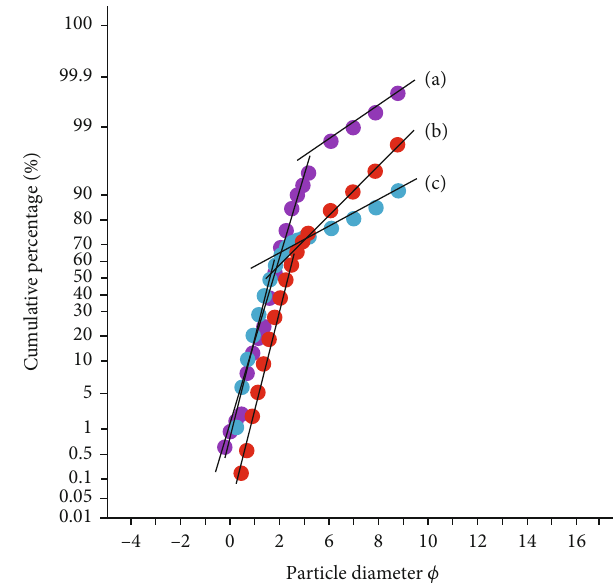
Figure 1: Granularity analysis of Nanpu 1-29 Area: (a) well NP12- 86, 2773.07m; (b) well NP12-43, 3014.13m; (c) well NP12-X77, 2773.07